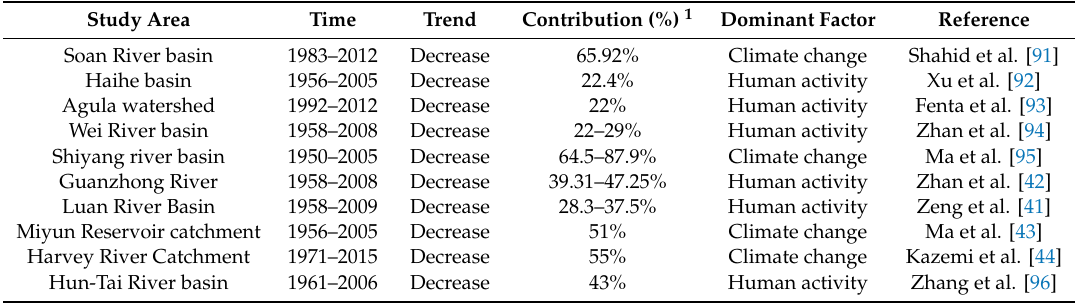
Table 3. Studies on the impact of climate change and human activities on runo ff based on the Budyko